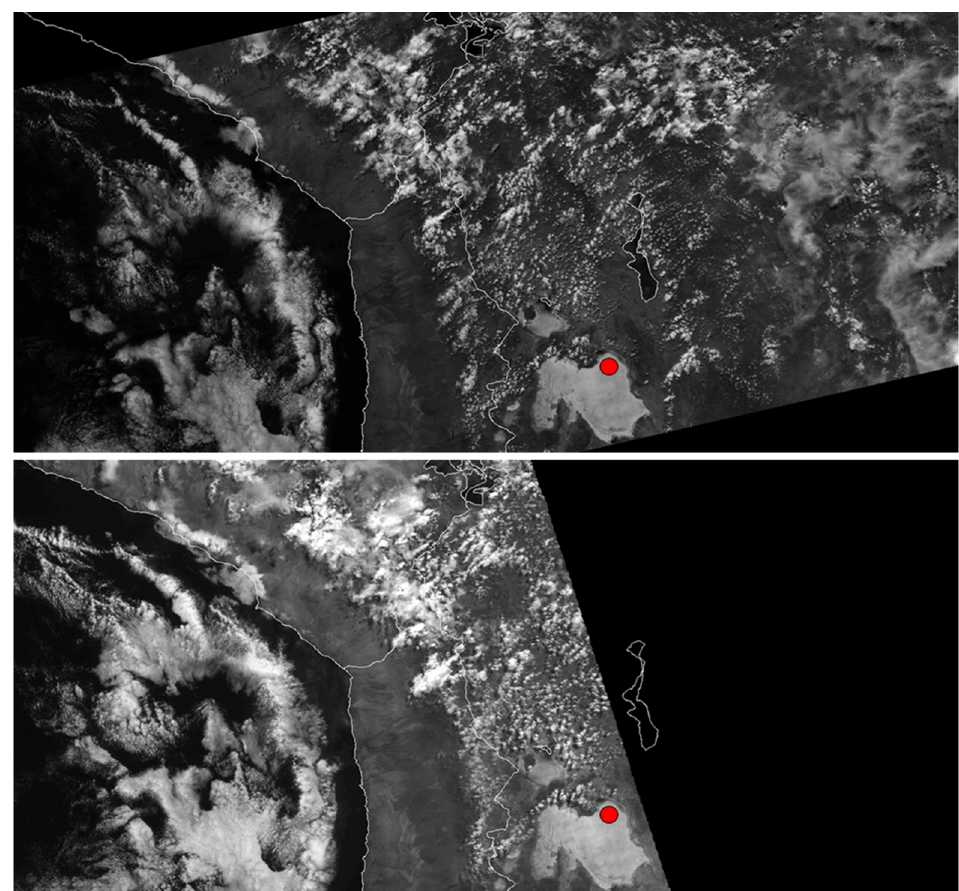
Figure 5. Visible (band I2) imagery of high-altitude regions of the central Andes (4000–6000 m MSL) viewed near nadir by NOAA-20 ( top ) and the near edge of the scan by S-NPP ( bottom ) with no apparent motion between the orbits. The red dot, located at the same point in each image, should be used as a reference. (The stability of land features, such as the “Salar de Uyuni” salt flat in the bottom of both images is best seen when the imagery is overlaid and toggled) .